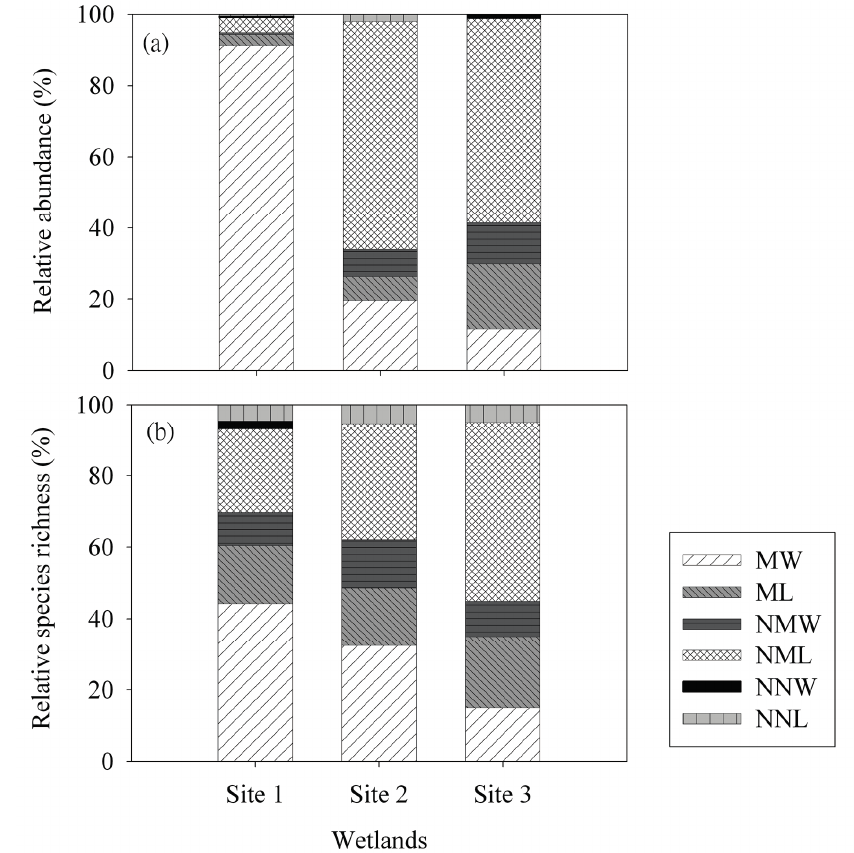
Figure 2. The percentages of ( a ) the relative abundance (observation per unit sampling effort) and ( b ) the relative species richness of birds for different ecological categories recorded in the three study wetlands. Different ecological categories of birds: MW = migratory waterbirds; ML = migratory landbirds; NMW = non-migratory waterbirds; NML = non-migratory landbirds; NNW = non-native waterbirds; NNL = non-native landbirds. See Figure 1 for site